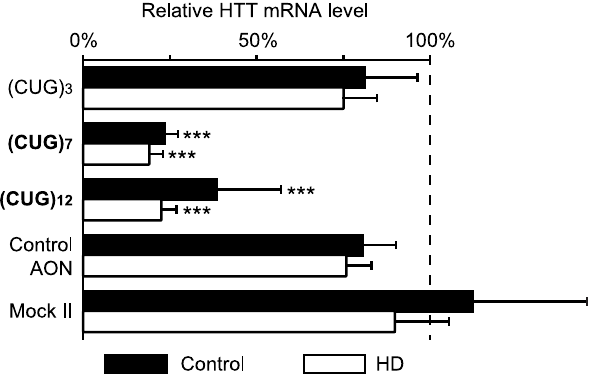
Figure 1. Number of CUGs of AON influences the reduction of HTT transcript levels. Total RNA was isolated 48 hours after transfection. Quantitative RT-PCR was used to measure HTT mRNA levels in control and HD fibroblasts after treatment with 100 nM (CUG) 3 , (CUG) 7 , (CUG) 12 AON, 100 nM non-htt specific h40AON2 (Control AON), transfection agent only (Mock II), or non-transfected cells (Mock I, not included in this figure). ACTB and RPL22 are used as reference genes. The expression level of Mock I transfections are set to 100%. For all transfections n=6 and *** P , 0.001).